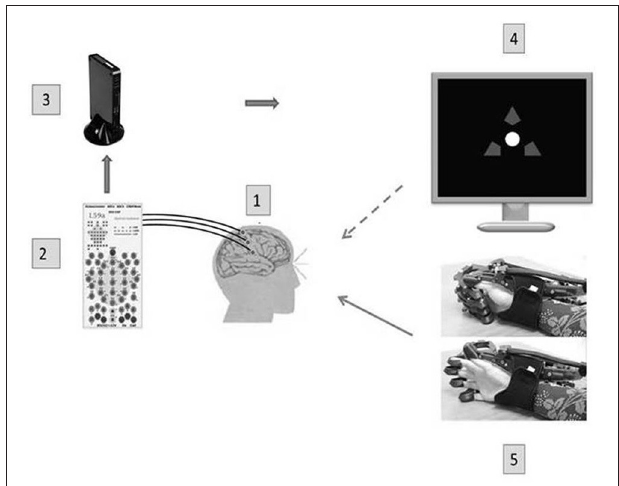
FIGURE 2 | A BCI-exoskeleton complex. A block diagram of the BCI complex used in this study: 1—32 Ag/AgCl EEC electrodes, 2—a NVX 52 encephalograph (Medical Computer Systems, Russia); 3—a computer (OS Windows 7): real time data transmission, identification of operational EEG parameters, recognition of a steering instruction; 4—a presentation monitor; 5—a hand exoskeleton (Neurobotics, Russia) with pneumatic actuators of finger extensors and spring flexors; flexed and extended exoskeleton configurations are shown. The dotted arrow denotes a visual feedback, and the solid arrow denotes a kinesthetic